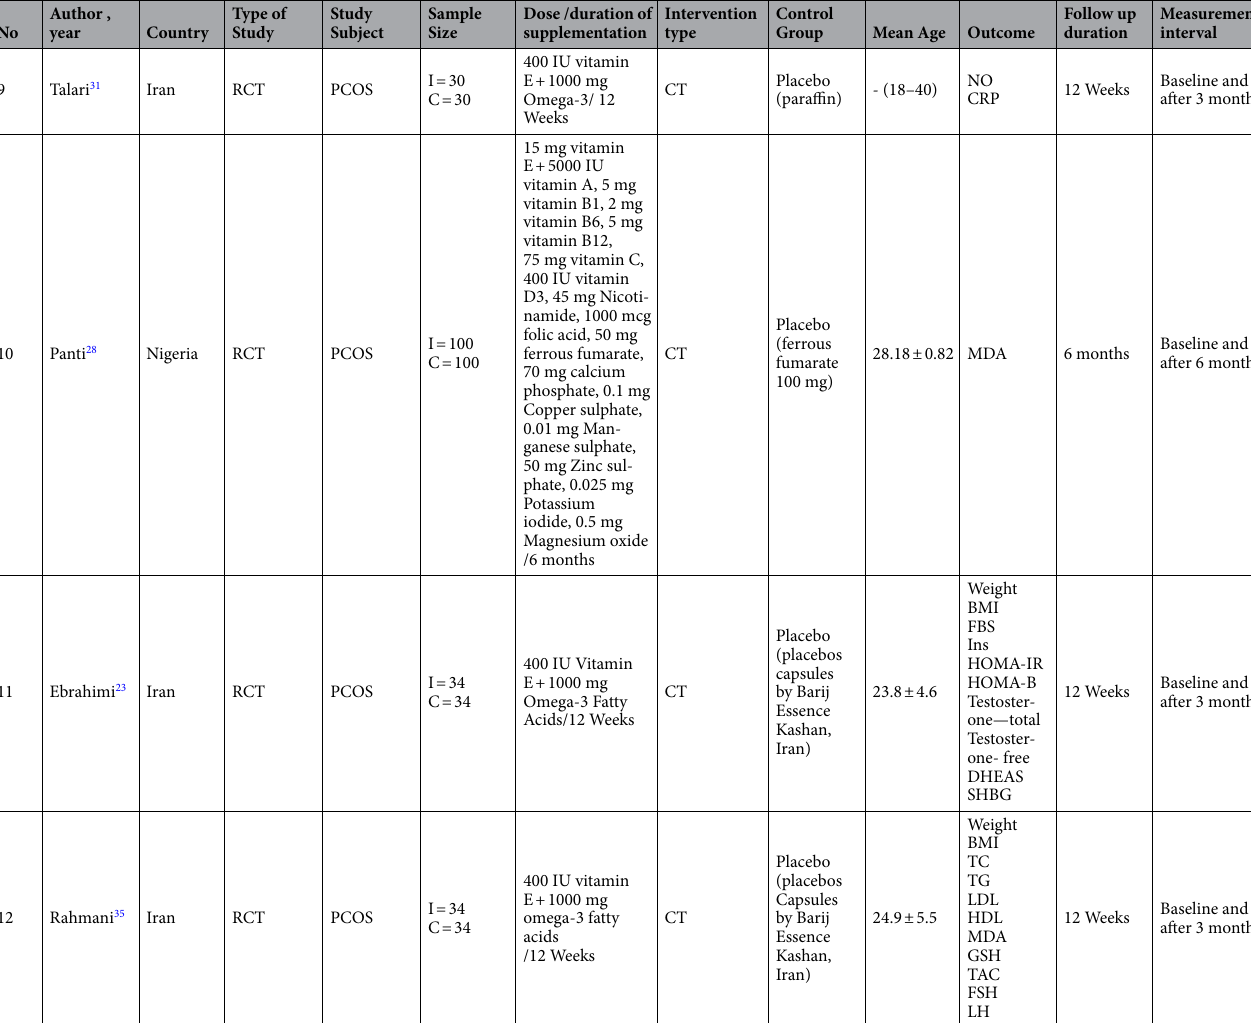
group consists of groups B and C with Vitamin E treatment during follicular and luteal phase,